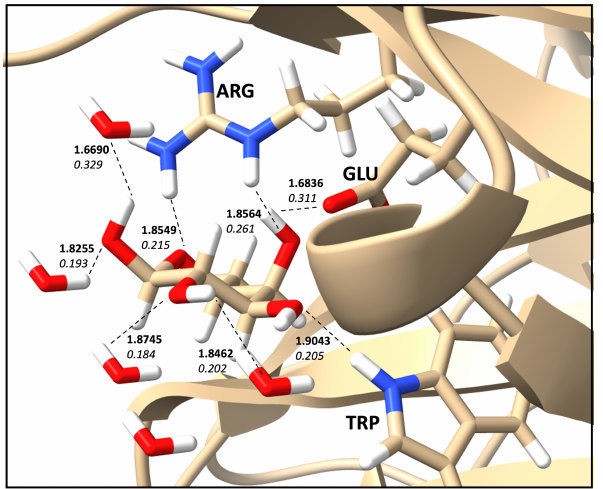
Figure 1. Optimized geometry of PDB ID: 1ofz with ligand from database B. The binding pocket is indicated by tick sticks, and hydrogen bonds are indicated by dashed lines. The XTB/GFN2-xTB level of theory was used. Table 1. Example analysis taken from database B for the PDB ID: 1ofz with ligand from database